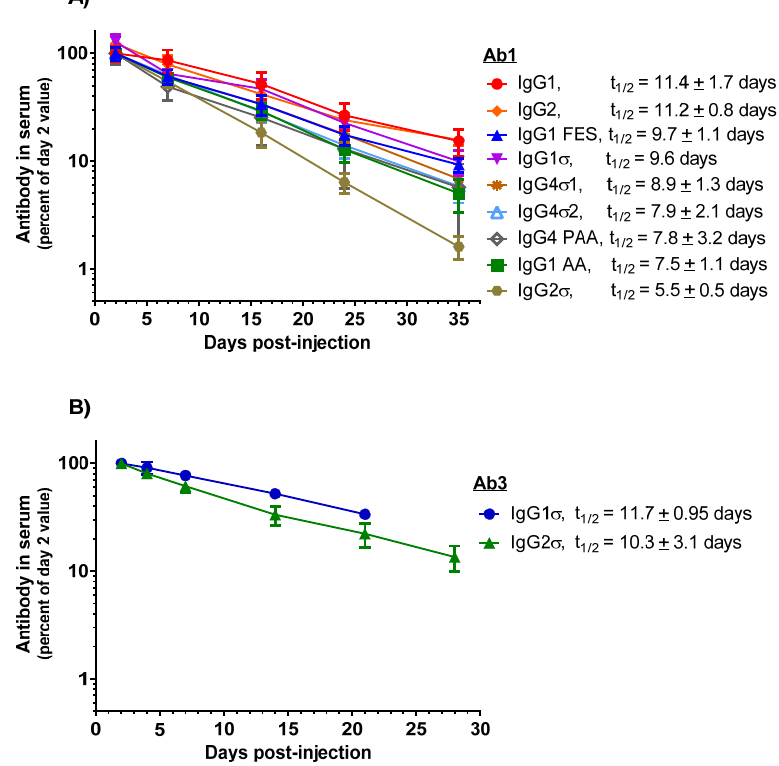
Figure 10. PK comparison of IgG1 WT and a panel of silent Fc variants in mice and cynomolgus monkeys. ( A ) Tg32 human FcRn transgenic mice were IV-injected with 2 mg/kg doses. Serum levels were expressed as a percent of day 2 values, the first timepoint. Data points represent the mean of 3 or 4 mice ± SEM. ( B ) Cynomolgus monkeys were injected intravenously with 1.5 mg/kg dose of an IgG2 σ version of Ab3 bispecific antibody and the mean PK profile was compared (in a separate study) with monkeys injected with 1.5 mg/kg of an huIgG1 σ version of Ab3. Similarly, IgG1 σ and IgG2 σ versions of Ab2 × Ab5 antibody were evaluated in the two separate studies.